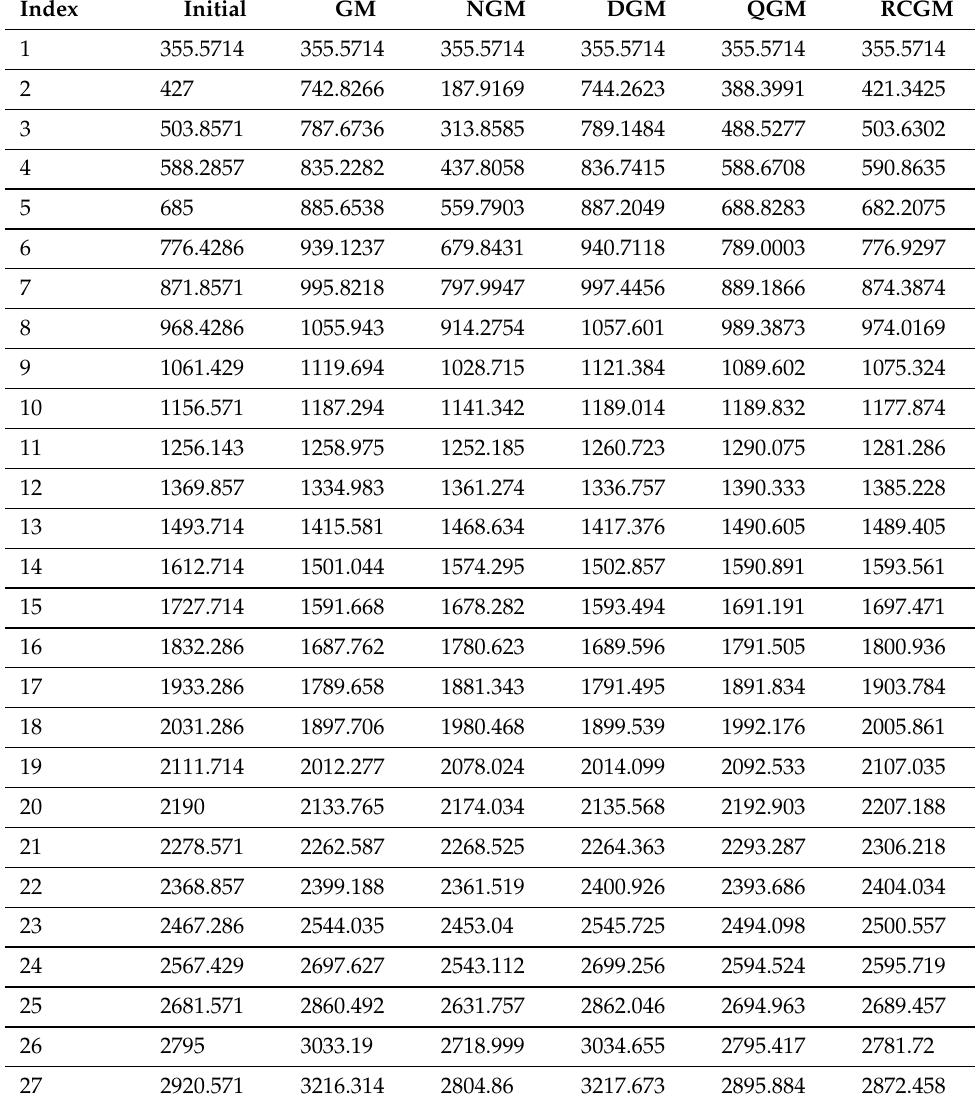
Table 8. Predicted values from Rajasthan data Model